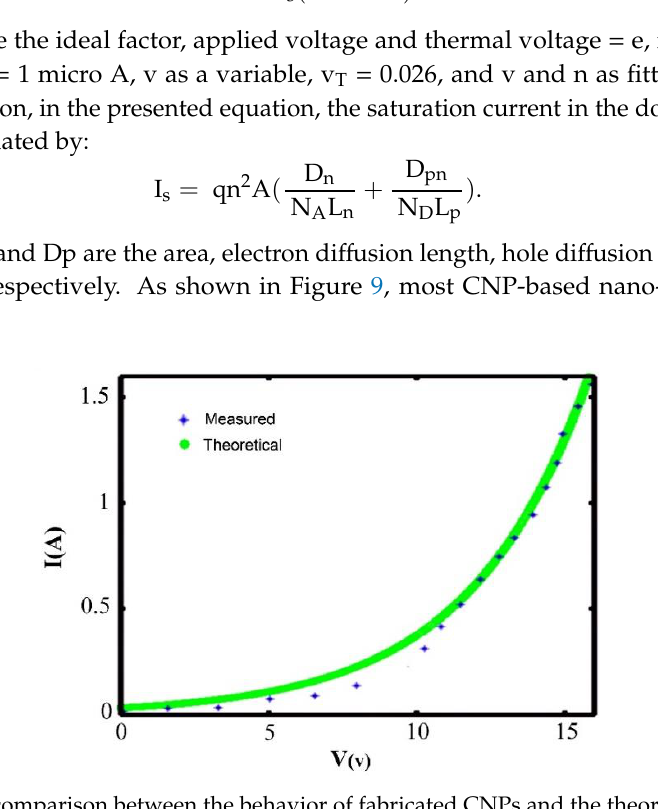
Figure 9. The comparison between the behavior of fabricated CNPs and the theoretical aspect.